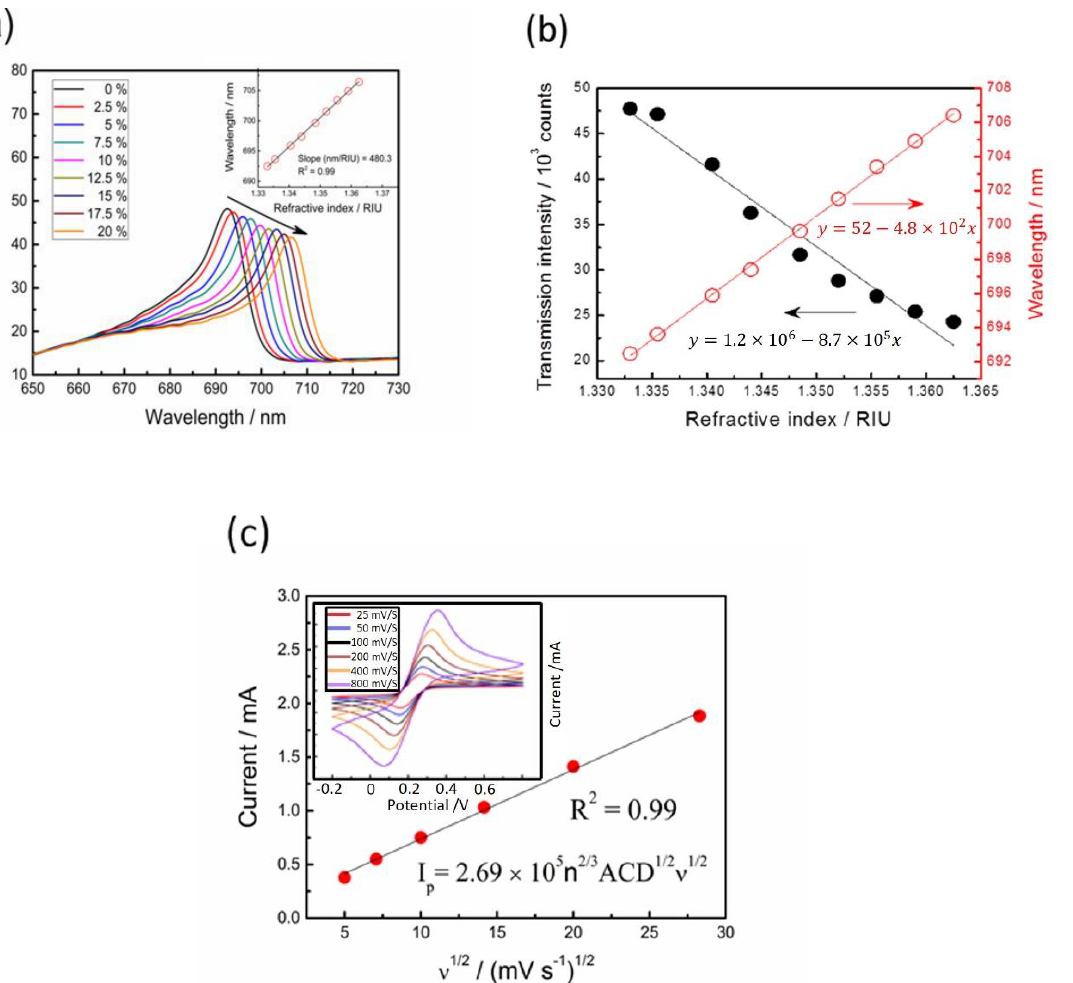
Figure 3. Characterization of the optical properties and electrochemical behaviors on EC-SPR sensors: ( a ) transmission spectra of capped gold nanoslit arrays in glycerol–water solutions with different environmental refractive indices; ( b ) the intensity and wavelength changes as a function of refractive index; ( c ) the relationship between the square root of scan rate and peak current from cyclic voltammograms.